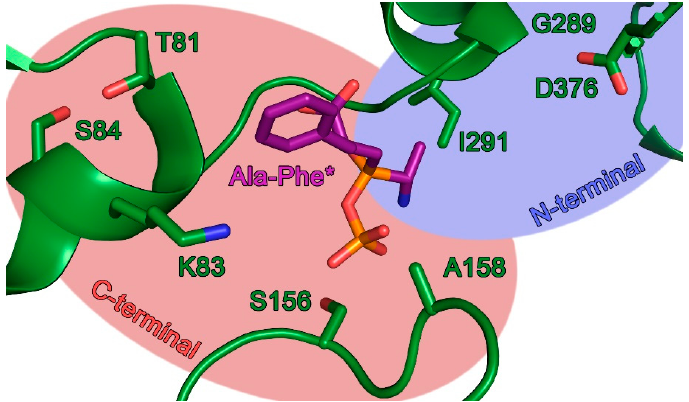
Figure 1. Mutated residues of RizA (green) in the C-(red) and N-terminal (blue) binding pocket (PDB ID: 4wd3). The structure contains the phosphorylated phospino-analog of L -Ala- L -Phe (pur- ple) from the structural alignment with BacD (PDB ID: 3vmm). Structures were displayed using PyMOL [29]